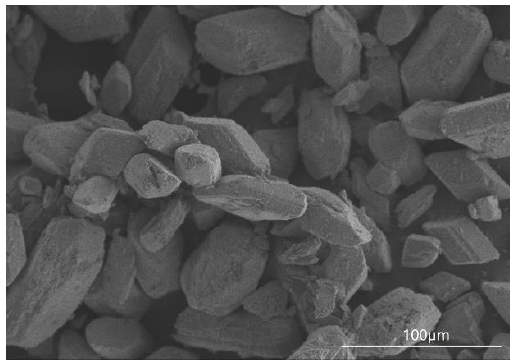
Figure 2. Morphology of the FGD gypsum crystals.